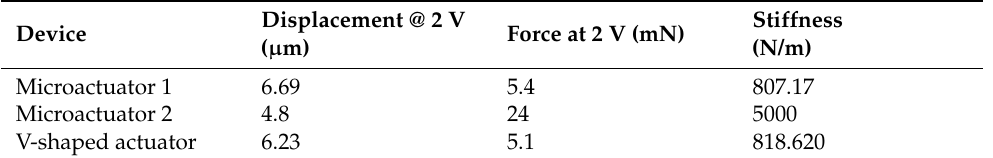
Table 7. Comparison of performance parameters of microactuators 1 and 2, and the V-shaped microactuator obtained by simulation in